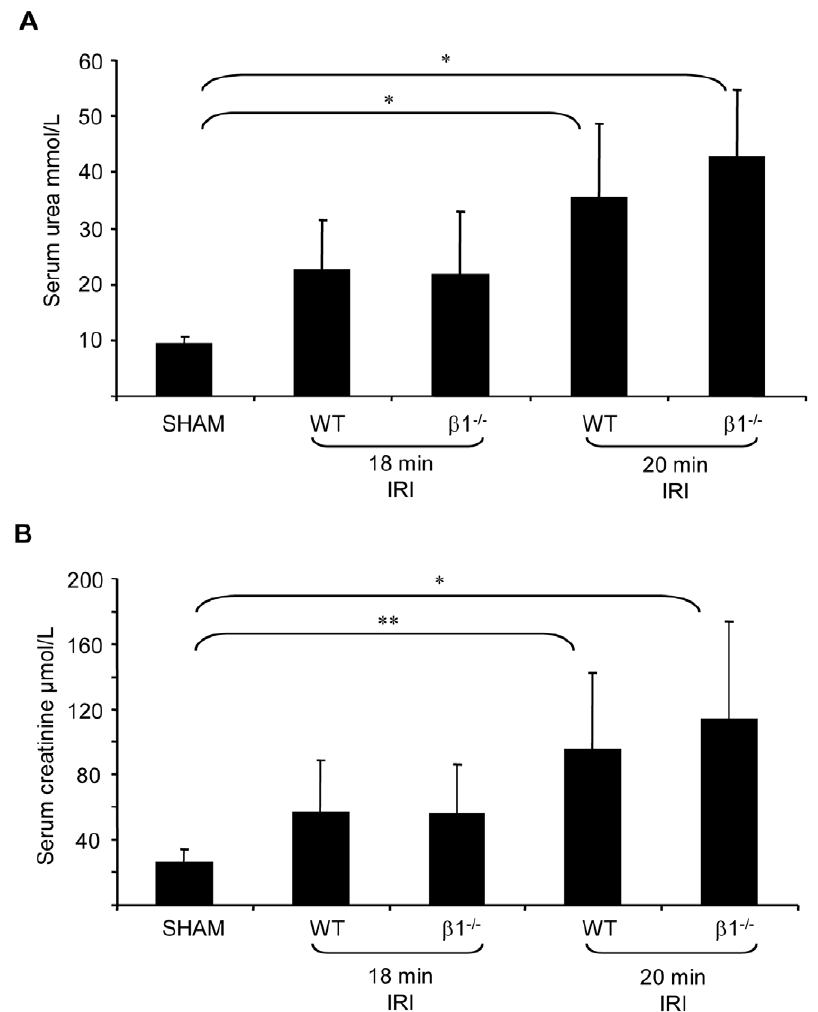
Figure 3. Severity of renal ischemia-reperfusion injury in wild type and AMPK- b 1 2 / 2 mice assessed by serum urea and creatinine at 24 hours post IR. Serum urea (A) and creatinine (B) were measured 24 hours post renal IR for 18 or 20 minutes in WT and AMPK- b 1 2 / 2 mice (n=6– 13 per group). Results are shown as mean 6 SD. * P , 0.001, ** P , 0.01. No significant differences between WT and AMPK- b 1 2 / 2 mice were observed.